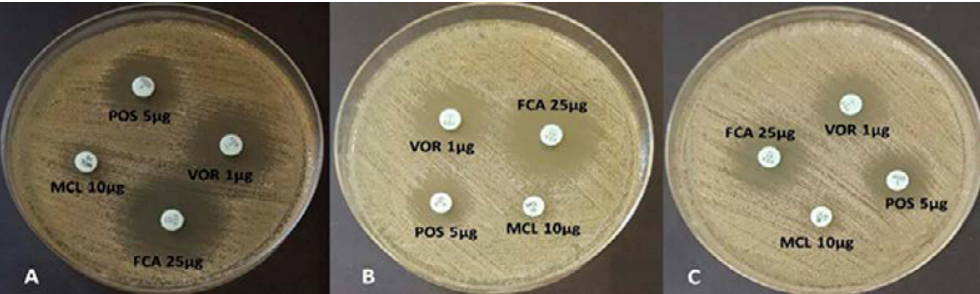
Fig. 3. Susceptibility pattern of Candida albicans biofilms on PVC-ETT against azoles: (A) 24-h, (B) 48-h, (C) 72-h; FCA: fluconazole, MCL: miconazole, POS: posaconazole, VO: voriconazole.